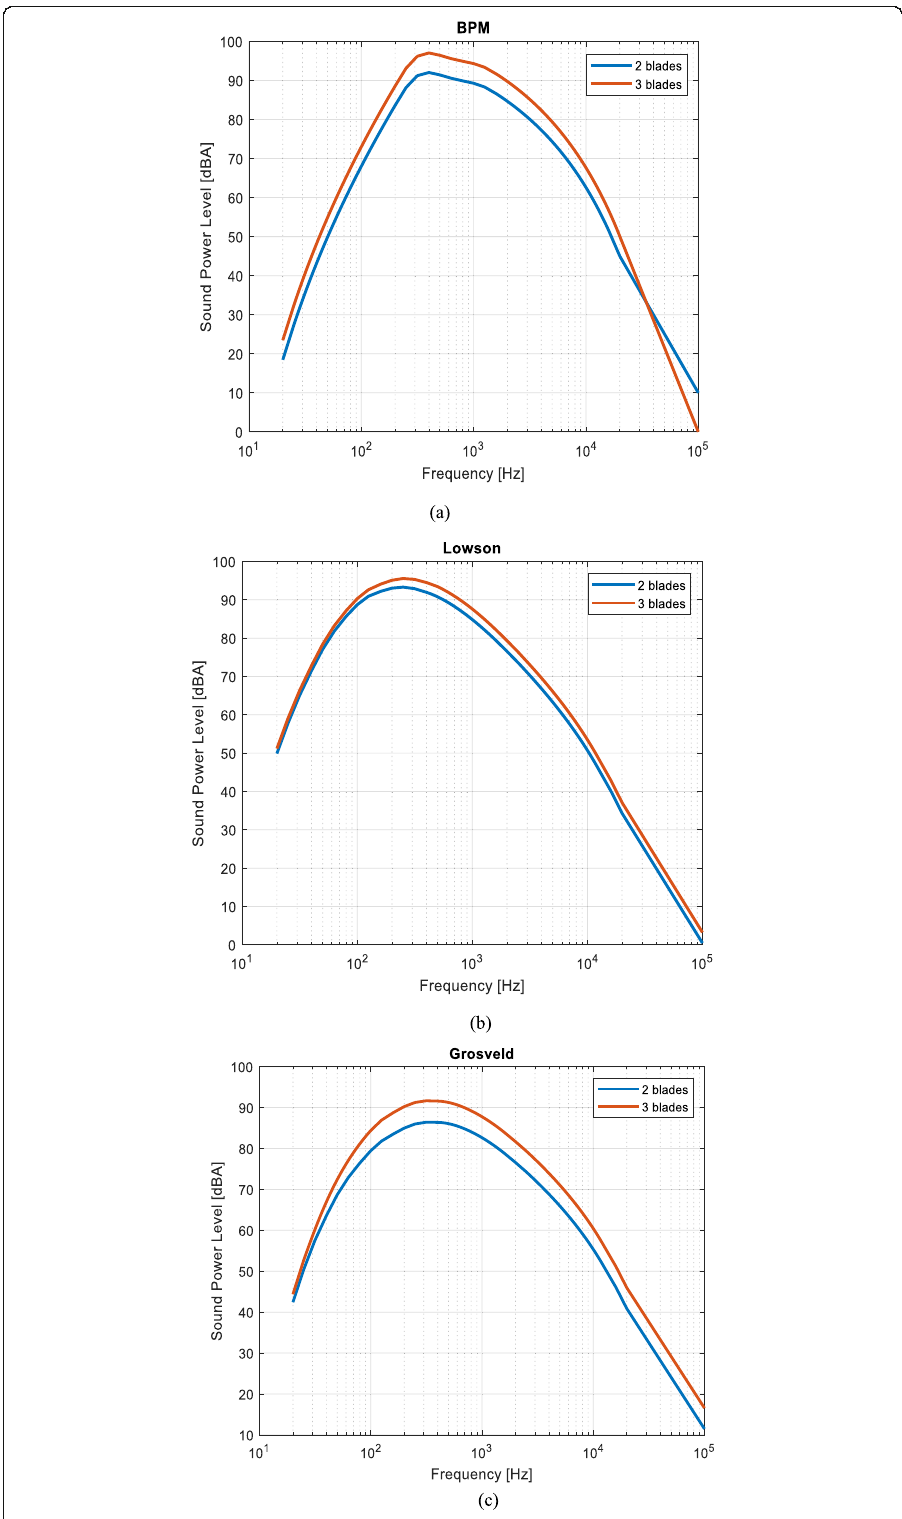
Fig. 7 Comparison of sound power level [dBA] for TBL-TEN source, using three trailing edge noise methods for a 2 MW wind turbine rotor with two and three blades at U 10 = 10 m/s. a BPM ( b ) Lowson ( c )